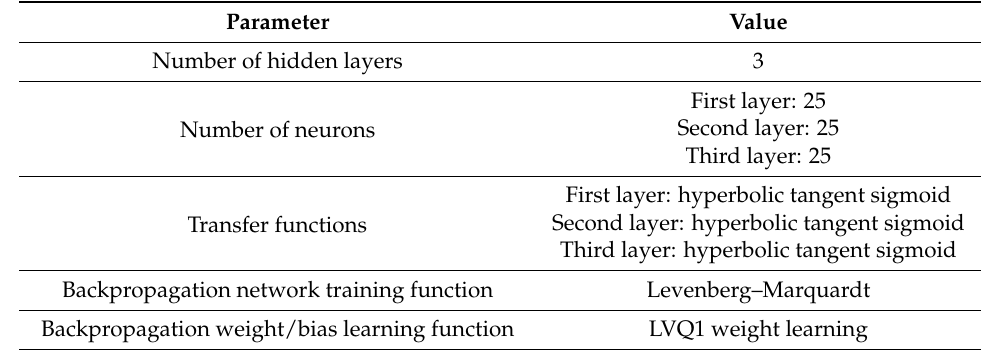
Table 4. Values of the multilayer perceptron artificial neural network parameters adjusted by the cultural algorithm (ANN-CA